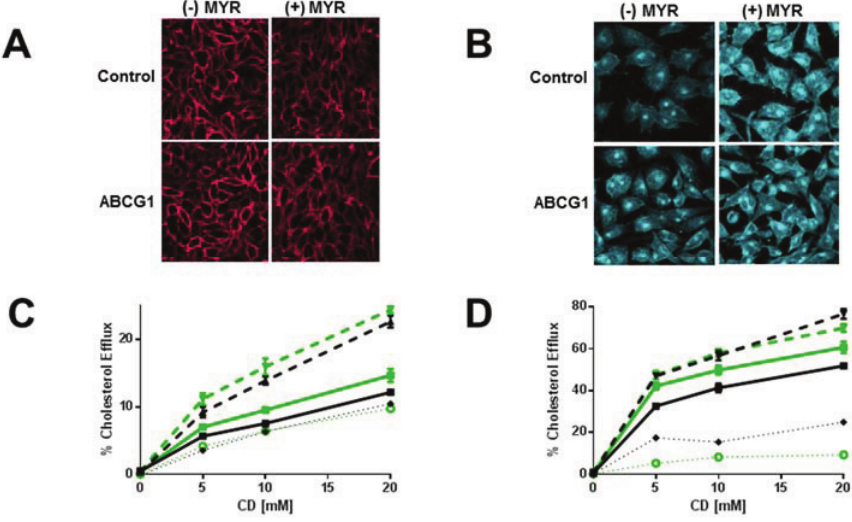
Figure 6. Myriocin reduces PM SM content and increases non-SM-associated cellular cholesterol pools and cholesterol efflux. ( A ) Myriocin reduces PM SM content. Control and ABCG1 cells pre-treated without myriocin (((cid:4)) MYR), or, with myriocin ((+) MYR) were immunostained with lysenin. ( B ) Myriocin increases cellular FC. Control and ABCG1 cells treated without (((cid:4)) MYR), or, with ((+) MYR) were stained with filipin. ( C ) Myriocin enhances CD-mediated PM FC efflux. Control ( black line ) and ABCG1 ( green line ) cells labeled with 3 H-FC were pre-treated without or with myr ( solid and dashed lines , respectively), and the percent of total cellular FC efflux CD (1 h at 4 °C) was determined. ( D ) Myriocin enhances CD-mediated cellular FC efflux. Control ( black ) and ABCG1 ( green ) cells labeled with 3 H-FC were pre-treated without or with myr ( solid and dashed lines , respectively), and the percent of total cellular FC efflux to CD (10 min at 37 °C) was determined. Myriocin enhances FC efflux to PC liposomes ( E ) and to HDL ( F ). ( E , F) : Black line , dashed black line : untreated, and myr-treated control cells, respectively; green line , dashed green line : untreated, and myr-treated ABCG1 cells, respectively. Dotted black and green lines represent difference curves for control and ABCG1 cells with myriocin treatment, respectively. All values are expressed as mean ± S.D. Data shown is representative of at least three replicate experiments. Two-way ANOVA analyses using multiple comparisons revealed that in ( C ), all values are significantly different ( p < 0.0001). In ( D ) all values are significantly different, except for control cells treated with myriocin (black dashed line ) vs . ABCG1 cells treated with myriocin (green dashed line) at 5 and 10 mM CD ( p >0.9999 and p = 0.9940, respectively). In ( E ), all values are significantly different ( p < 0.0001) except for control cells (black solid line) vs . control cells treated with myriocin (black dashed line) at 25 μg/mL PC ( p = 0.5727) and, ABCG1 cells (green solid line) vs . ABCG1 cells treated with myriocin (green dashed line) at 25 and 50 μg/mL PC liposomes ( p = 0.9998 and p = 0.3189, respectively). In ( F ), all values for untreated control cells (solid black line) are significantly different from untreated ABCG1 cells (solid green line), p < 0.0001. The values for percent cholesterol efflux did not significantly differ at 25, 50 or, 100 μg/mL HDL for myriocin-treated control cells (dashed black line) vs . ABCG1 cells (solid green line) or myriocin-treated ABCG1 cells (dashed green